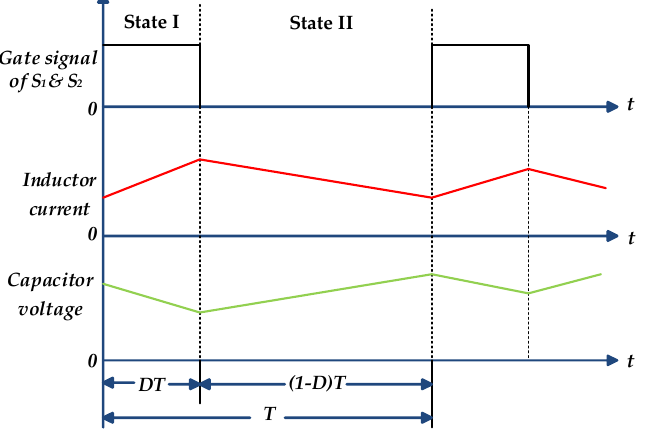
Figure 3. The gating sequence of the HS-SZC.